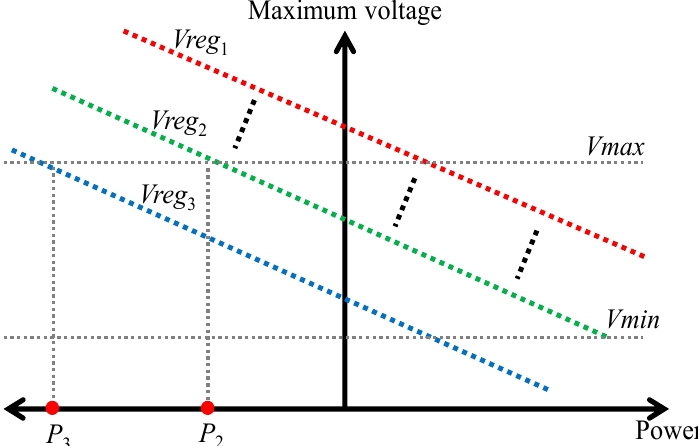
Figure 1. A graphical example of the relationships between the power at the distribution transformer and the maximum voltage at residential customers for different LV busbar voltage.